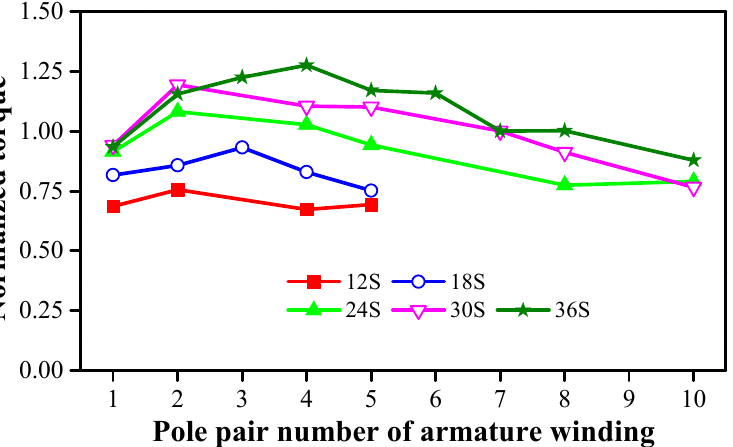
Figure 11. Torques versus armature pole pair number and stator slot number when rotor slot number is selected as N s − P a .